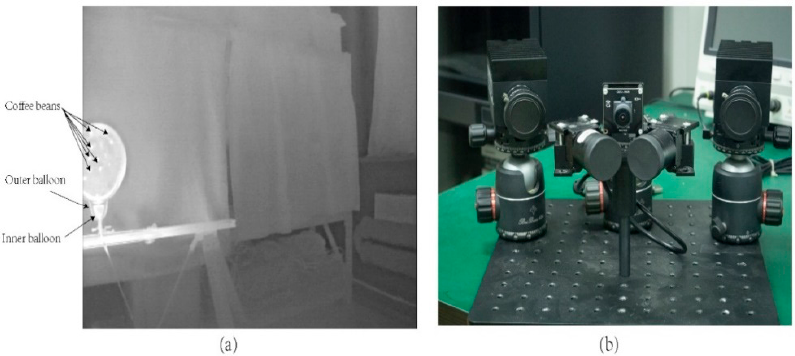
Figure 5. ( a ) Constructed balloons for explosion under long ‐ wavelength infrared (LWIR) view, ( b ) measurement instruments with the monitoring module in the